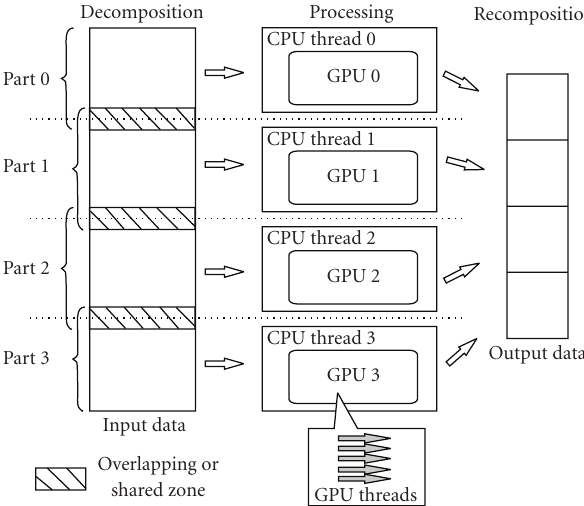
Figure 6: Data assignment scheme for multiGPU processing.